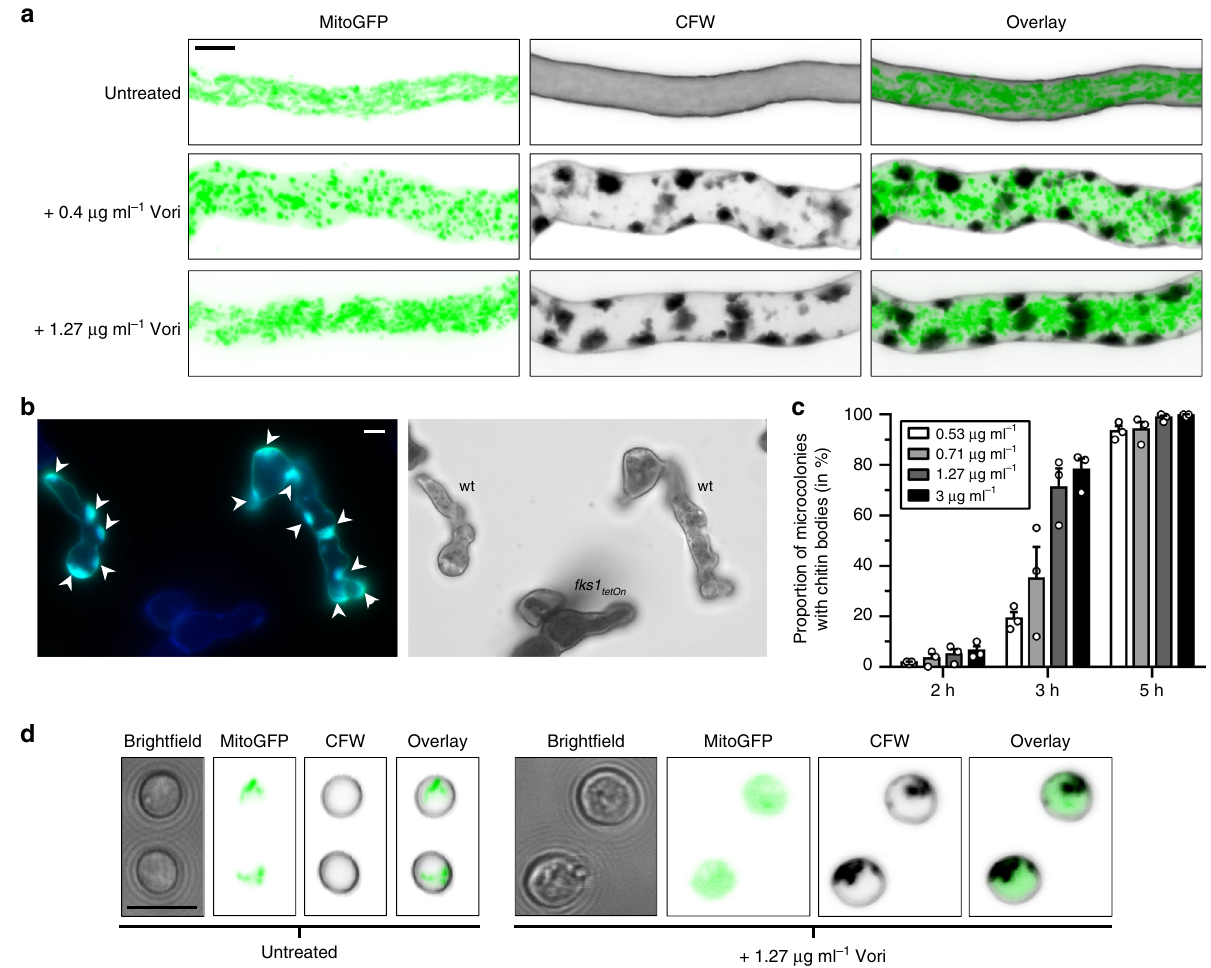
Fig. 2 Inhibition of the lanosterol 14 α -demethylase triggers excessive synthesis of cell wall carbohydrates at de fi ned foci. a – c Conidia of A . fumigatus wild- type expressing mitochondria-targeted GFP ( a ), cytosolic GFP ( b ), or no GFP ( c ) were inoculated in Sabouraud medium on cover slips and incubated at 37 °C. The experiment depicted in b was additionally inoculated with conidia of a conditional β -1,3-glucan synthase mutant under repressive conditions ( fks1 tetOn ; staining control). a When indicated ( + Vori), medium was supplemented with 0.4 or 1.27 µ g ml − 1 voriconazole 10 h after inoculation. After a total of 15 h incubation, hyphae were fi xed, stained with calco fl uor white and analyzed with a confocal laser scanning microscope. Depicted are representative images of optical stacks of mitochondria (GFP; left panels), chitin (calco fl uor white; middle panels) and an overlay (right panels) that cover the entire hypha in focus. b After 8 h incubation, medium was supplemented with 1.27 µ g ml − 1 voriconazole. After additional 9 h incubation at 37 °C, hyphae were fi xed, stained with aniline blue and immediately analyzed with a fl uorescence microscope. Left, glucan-speci fi c (green) and nonspeci fi c ( fks1 tetOn ; blue) aniline blue fl uorescence. Right, bright fi eld microscopy. Arrow heads indicate glucan patches. c After 7 h incubation, medium was supplemented with the indicated amount of voriconazole. After 2, 3, and 5 h co-incubation, samples were fi xed and stained with calco fl uor white. The percentage of microcolonies with chitin patches was determined with a fl uorescence microscope and plotted in the depicted graph. Bars represent means of the indicated data points, error bars indicate standard deviations. Data are representative of three independent blinded experiments. d Wild-type conidia expressing mitochondria-targeted GFP were stained with calco fl uor white, either directly (resting conidia; left panel) or after 45 h incubation at 37 °C in Sabouraud medium supplemented with 1.27 µ g ml − 1 voriconazole (right panel). Depicted are representative bright fi eld images (left), images of single GFP (middle left) and calco fl uor white (middle right) fl uorescence cross sections and an overlay of both (right). a , b, and d Bars represent 5 μ m and are applicable to all